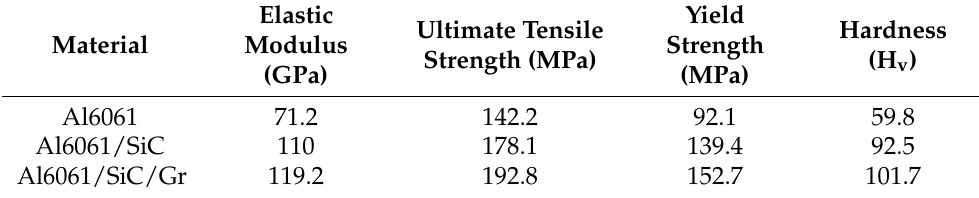
Table 1. Comparison of mechanical properties.